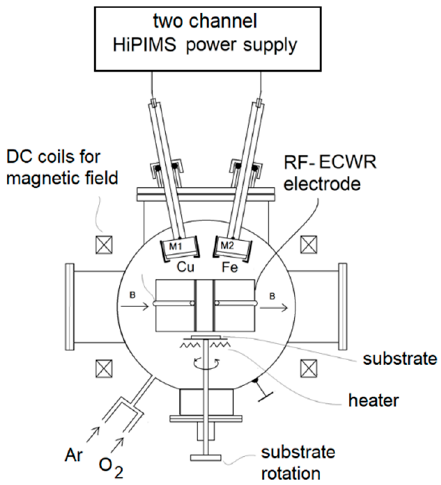
Figure 1. Experimental apparatus with two magnetrons and the radio frequency (RF) electron